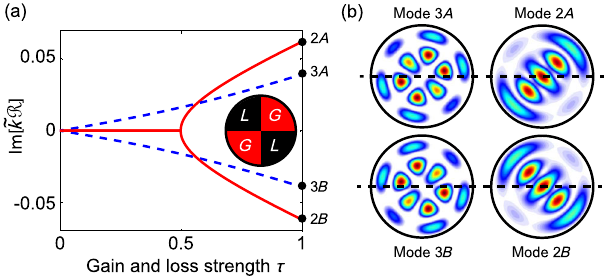
FIG. 3. Partial transitions with additional discrete symmetries. (a) Same as Fig. 1 for the m ¼ 2 ; 3 modes but with uniform gain or loss in each of the four quadrants, which is described by the generalized dihedral group DT 2 with v ¼ 4 (see Sec. III C). v Dashed lines show the absence of the standard PT phase transition for the m ¼ 3 modes. Solid lines show the standard PT phase transition for the odd-parity m ¼ 2 mode coupled to a nearby 0 . 498 is well approximated m ¼ 0 mode. Their threshold τ TH ¼ 0 . 483 . The pairing even-parity by Eq. (6), which gives τ TH ¼ m ¼ 2 mode stays in the PT symmetry phase in the range shown. (b) Intensity profiles of the four modes at τ ¼ 1 . The m ¼ 3 modes are slightly perturbed from those in Fig. 1 due to their weak coupling to a pair of m ¼ 1 modes nearby as τ becomes